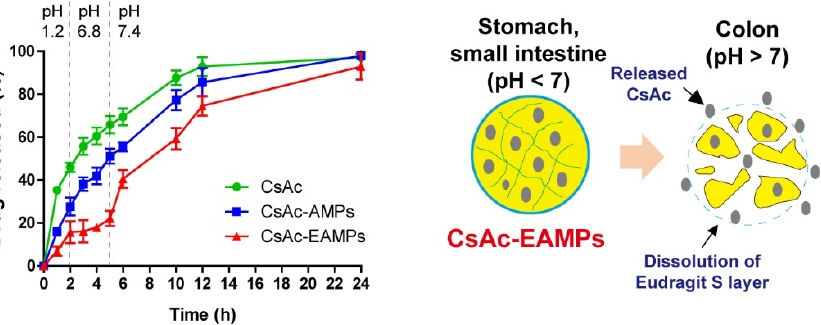
Figure 2. Drug release profiles of CsAc, CsAc-AMPs, and CsAc-EPMPs in media under different pH conditions and the proposed pH-dependent drug release mechanism of CsAc-EAMPs. Data are expressed as means ± standard deviation ( n = 3). CsAc, cyclosporine A crystals; CsAc-AMPs, CsA crystal-loaded alginate microparticles; CsAc-EAMPs, CsA crystal-loaded, Eudragit S 100 coated alginate microparticles.